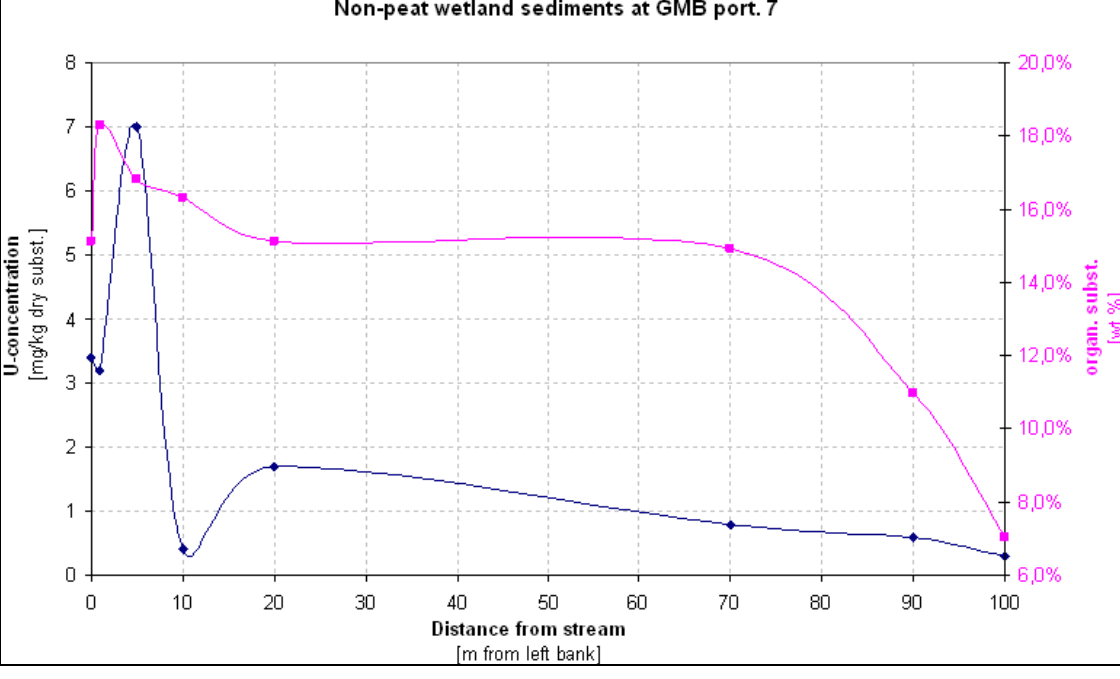
Figure 12. Stream-distance gradients of U in non-peat sediments at üortion 7 in relation to the associated contents of organic